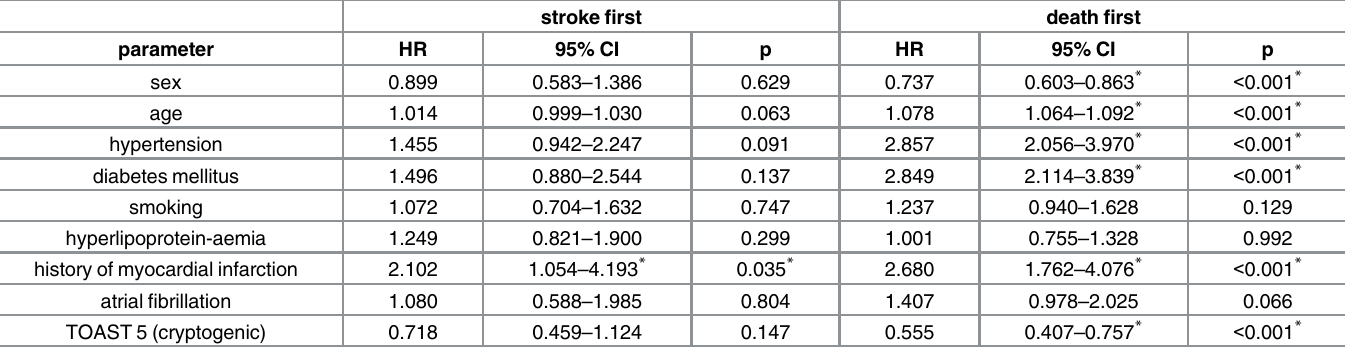
Table 3. Univariate analysis.